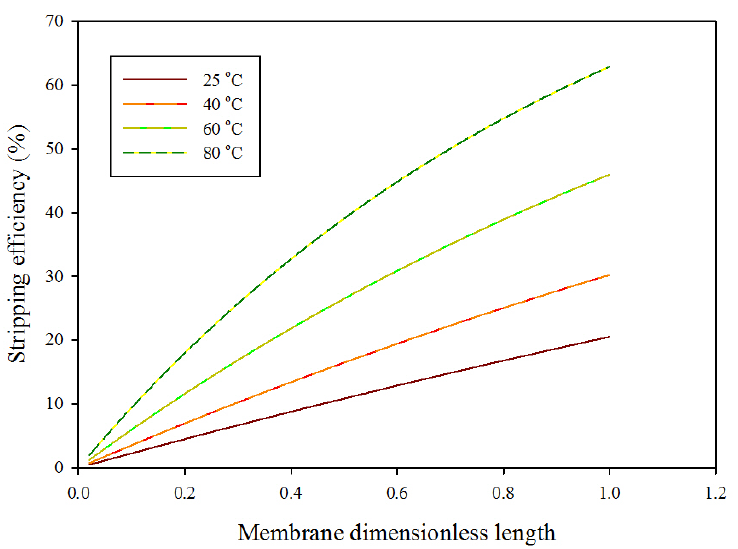
Figure 6. Stripping efficiency versus membrane dimensionless length at variable liquid solvent temperatures (25, 40, 60, and 80 °C); inlet gas flow rate is 600 mL/min and flow rate of inlet solvent is 20 mL/min.